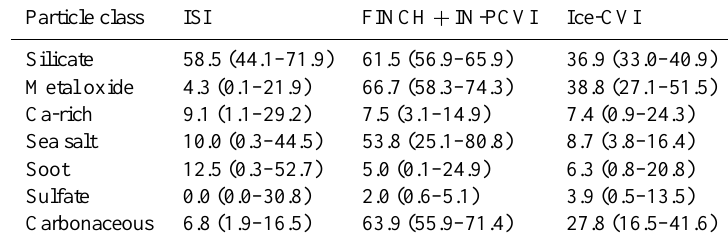
Table 3. Number fraction (%) of internally mixed particles in each particle class (95% confidence interval in parentheses).